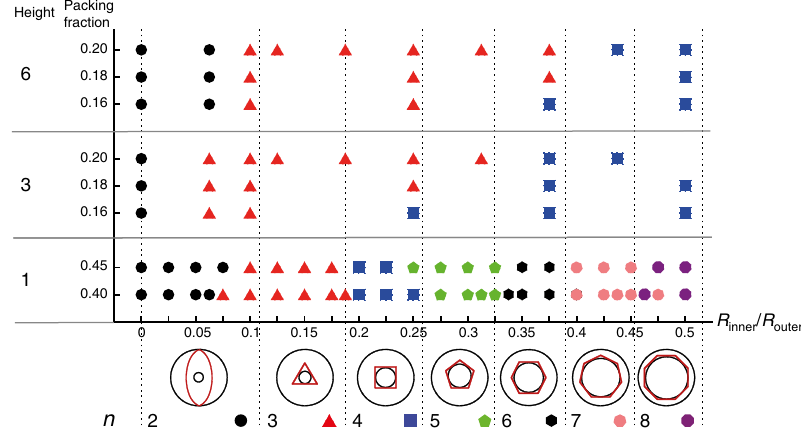
Figure 3 | Number of nematic domains in different geometries. The symmetry number n of the patterns observed in simulations as a function of the inner hole radius R inner for rods with aspect ratio L / D ¼ 15 in an annular geometry with R outer ¼ 40 D , for chamber heights H ¼ D (the strictly 2D case) and H ¼ 3 D , 6 D at a number of different packing fractions. Each coloured symbol represents a different pattern, the chosen shape indicating the symmetry as explained in the legend at the bottom. The dotted vertical lines mark the predicted boundaries between the different patterns based on the geometrical rule discussed in the main